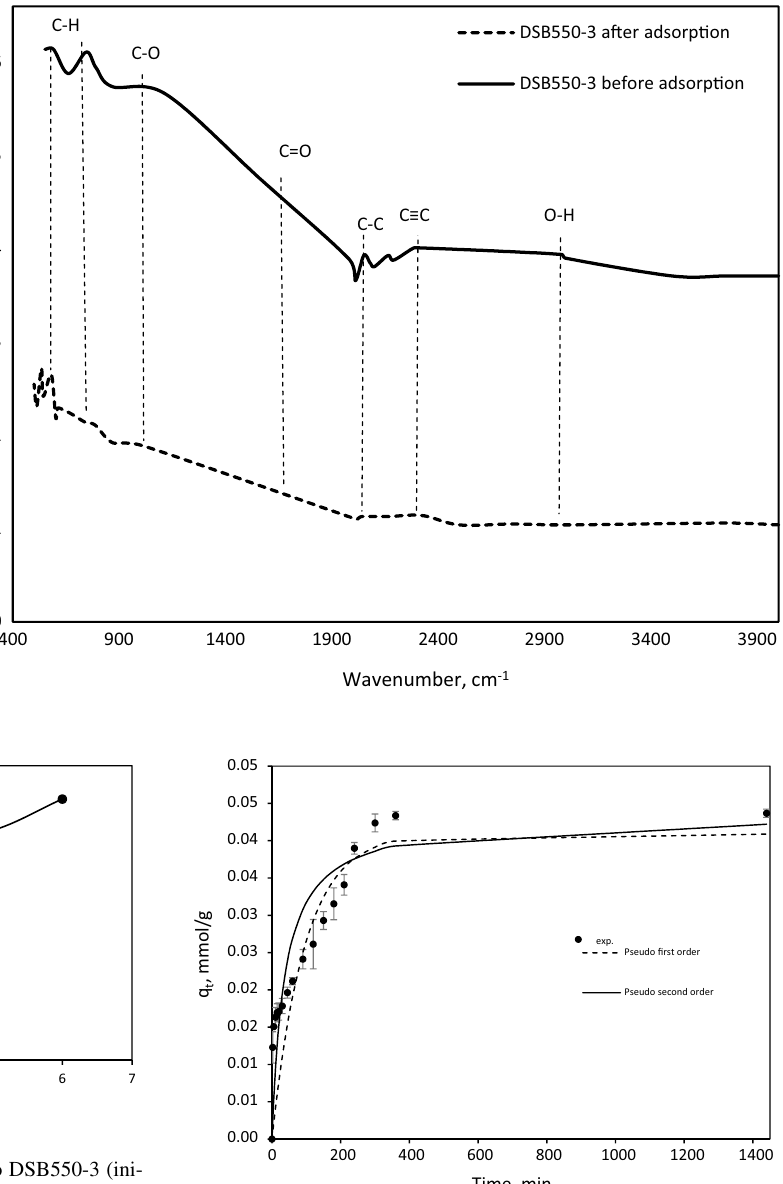
Fig. 5 Effect of contact time on Pb 2+ adsorption onto DSB550-3 (ini- tial Pb 2+ concentration = 0.5 mM; pH 6; room temperature; biochar: solution ratio = 10 g L −1 ; particle size = 0.6–1.4